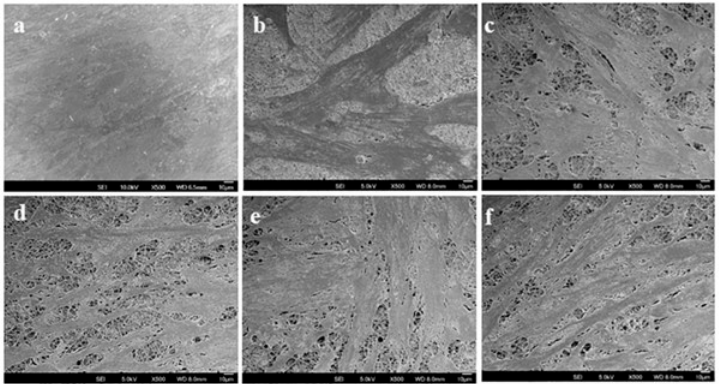
Figure 8. SEM images of fibroblast on the biocomposite nanofibrous scaffolds on day 9 ( a ) TCP, ( b ) PCL, ( c ) PCL/AV, ( d ) PCL/CUR, ( e ) PCL/AV/CUR, ( f ) PCL/AV/TCH.